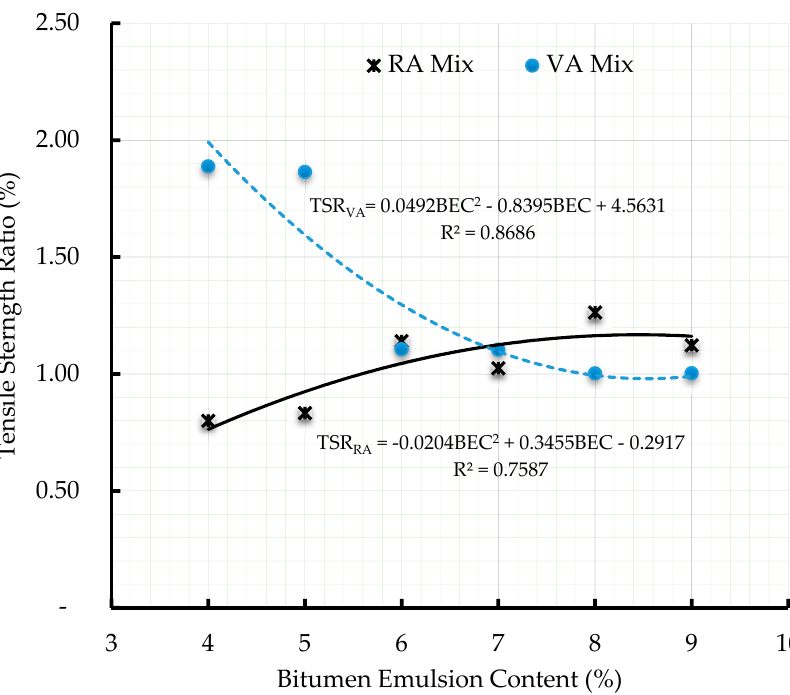
Figure 9. Tensile Strength Ratios for Virgin Aggregates and Reclaimed Asphalt Aggregates Mixes at Optimum Bitumen Emulsion Contents.